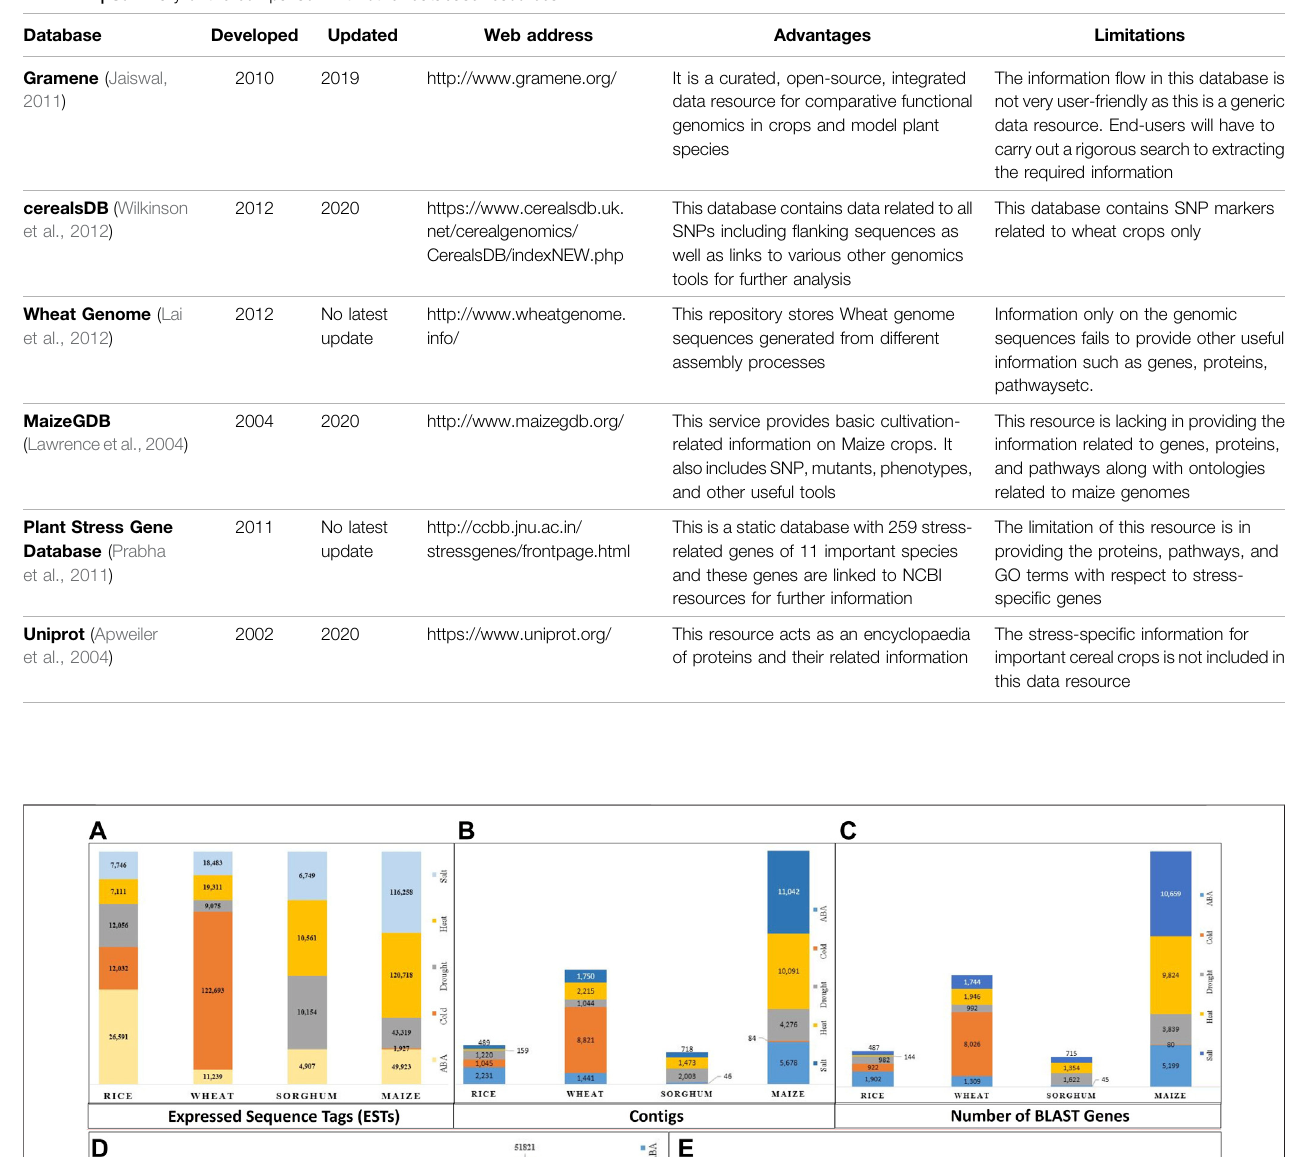
TABLE 1 | Summary of the comparison with other database resources.